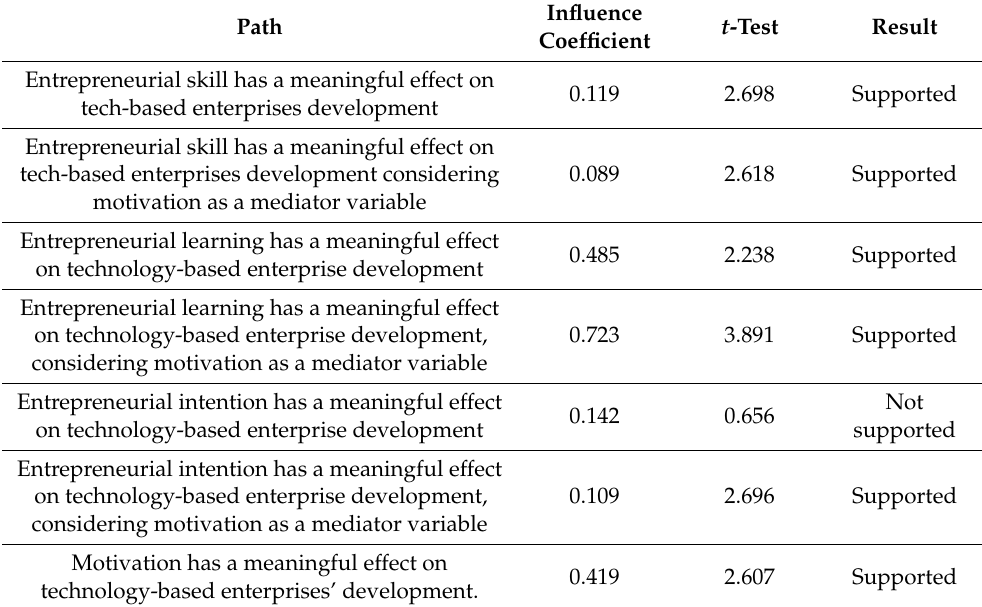
Table 4. t -test and influence